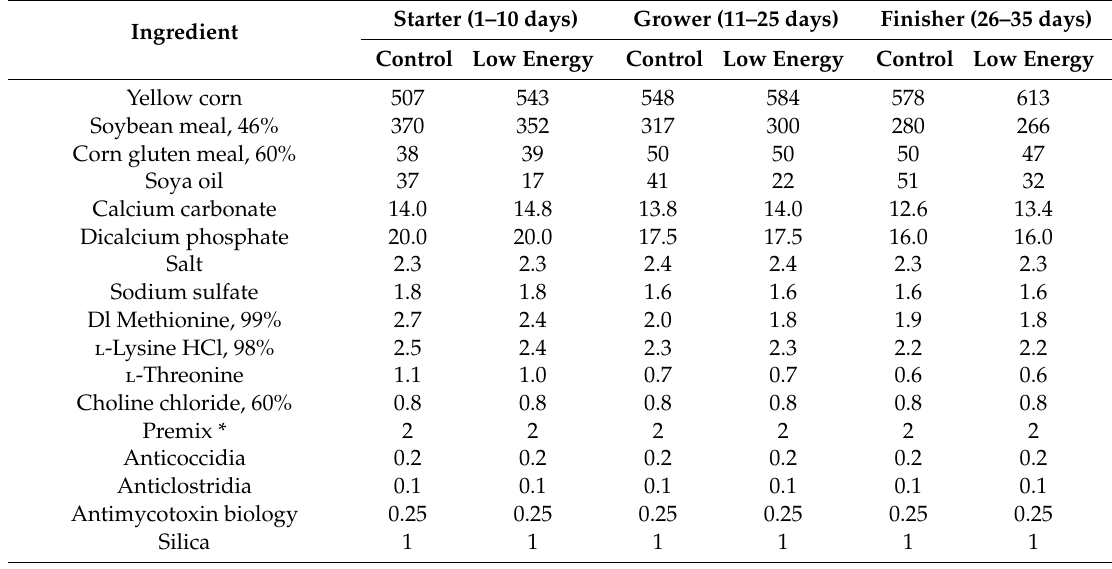
Table 1. Composition of the experimental starter, grower, and finisher